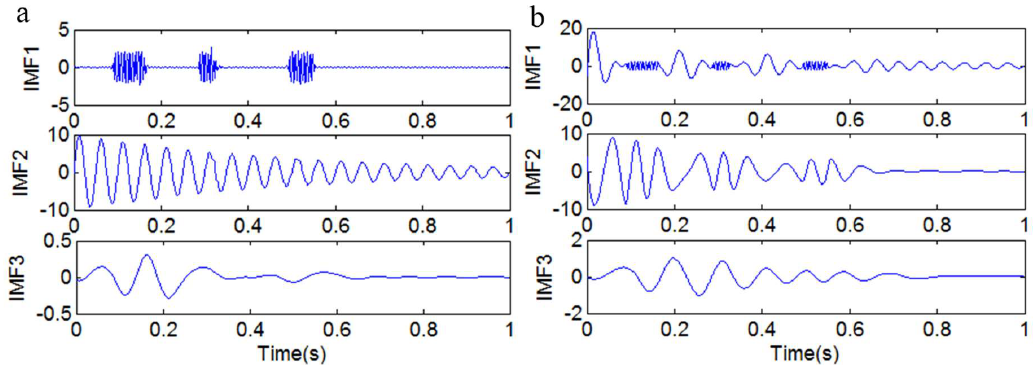
Figure 16. The first three IMFs. ( a ) The IMFs obtained by adding the sinusoidal signal y 13 ( t ); ( b ) the